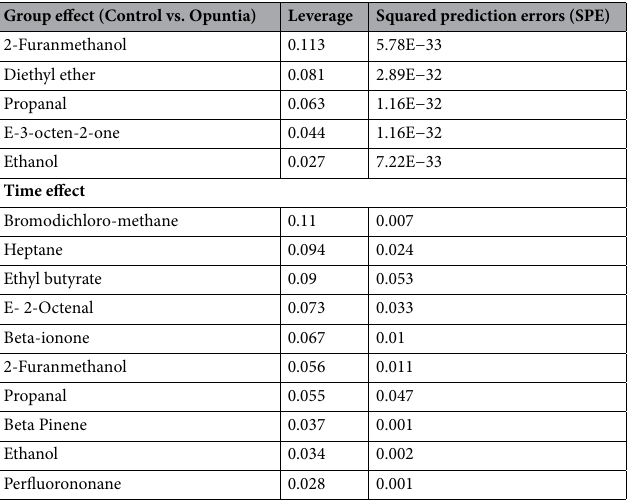
Figure 4. The important metabolites that contributed most significantly to the separation of treatments, according to the VIP scores using the above PLS-DA model before the start of dietary treatments. ( A ) Figure represents Day 0, ( B ) figure represents Day 30, ( C ) figure represents Day 45. Metabolomics data analysis was performed using the free web-based metabolomics tool (MetaboAnalyst 4.0; https:// www. metab oanal yst. ca/ home. xhtml) 54 . Group effect (Control vs.